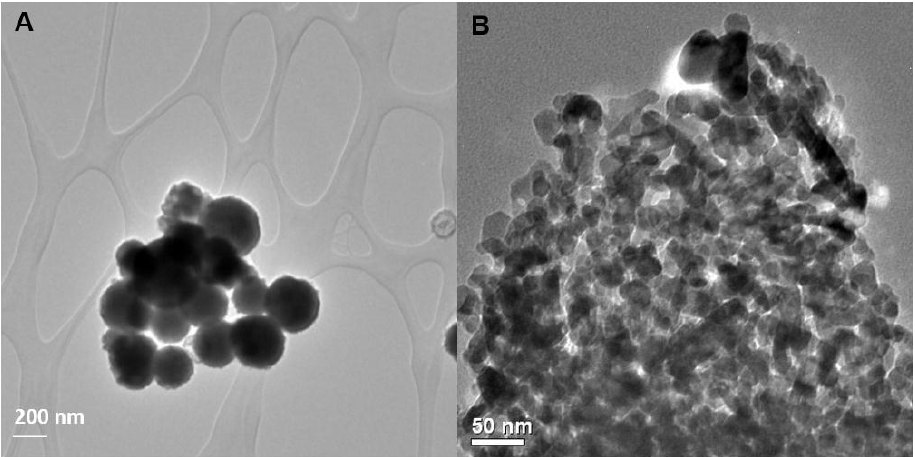
Figure 1. Transmission electron microscope (TEM) micrographs of ( A ) Zn nanoparticles (NPs) and ( B ) ZnO NPs. Table 1. Treatment characterization data. Hydrodynamic diameter (Z-average diameter) measurements taken 2 min after bath sonication and based on intensity weighted size distribution measurements. SD = Standard deviation.